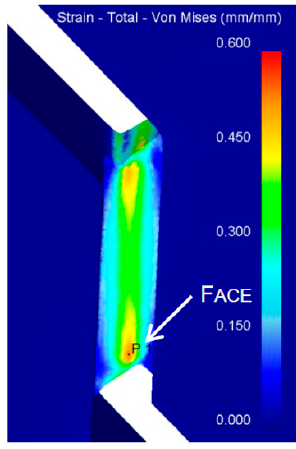
Figure 21. The fracture location in 2D simulation of notched tensile test.